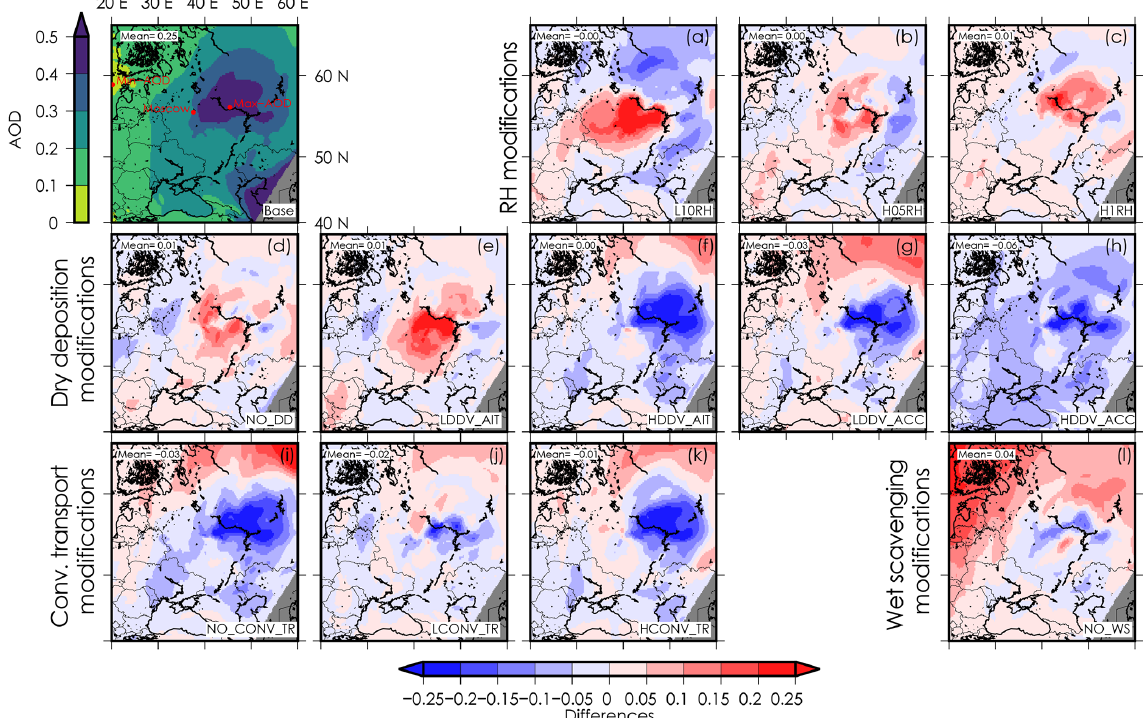
Figure 2. Modelled AOD at 550nm for the base case (top left) and mean bias differences between experiments and the base case. RH modifi- cations at the top right: (a) scaled to 0.9 (L10RH), (b) scaled to 1.005 (H05RH), and (c) scaled to 1.01 (H1RH). Dry deposition modifications in the second row: (d) the suppression (NO_DD), (e) the low DDV for the Aitken mode (LDDV_AIT), (f) the high (HDDV_AIT), (g) the low DDV for the accumulation mode (LDDV_ACC), and (h) the high (HDDV_ACC). Sub-grid convective transport are in bottom-right row: (i) the suppression (NO_CONV_TRANS), (j) scaled to 0.5 (LCONV_TRANS), and (k) scaled to 1.5 (HCONV_TRANS). Bottom-left panel (l) is the suppression of the wet